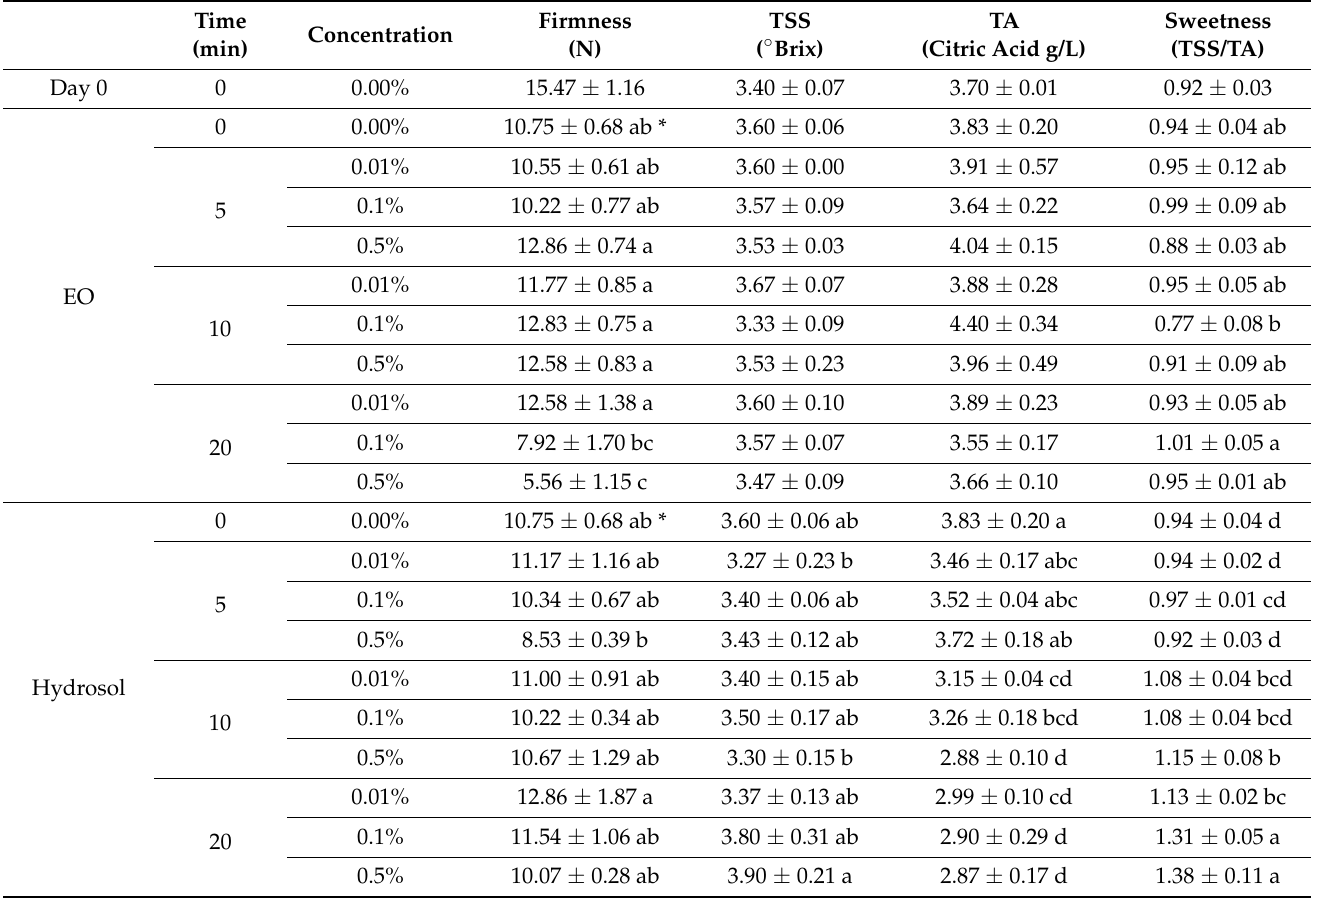
(Table 3). On the other hand, hydrosol at 0.5% for 5 min, 0.1% for 10 min and 0.5% for 20 min decreased the b* values compared to the control. Comparing the control, on the initial and last day, an increased b* value was reported during the latter. Table 1. Screening of O. dubium EO and hydrosol application effects on fresh tomato firmness, total soluble solids (TSS), titratable acidity (TA) and sweetness when stored at 11 ◦ C for 12 days. Values presented as mean ± standard error of four biological replicates per treatment. Measurements for day 0 refer to the control. In each column and for each treatment (EO and hydrosol), significant differences ( p < 0.05) are indicated with different Latin letters. For control (0.00%), the asterisk